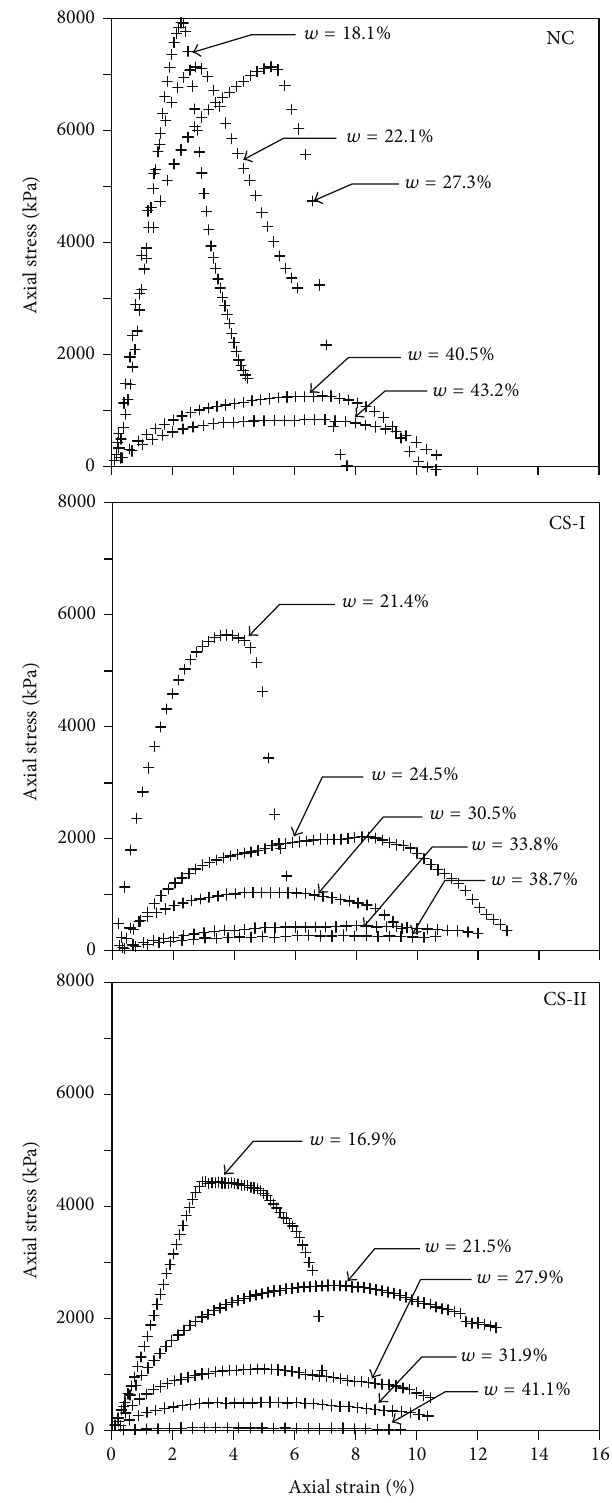
Figure 3: Stress-strain behaviour of the investigated